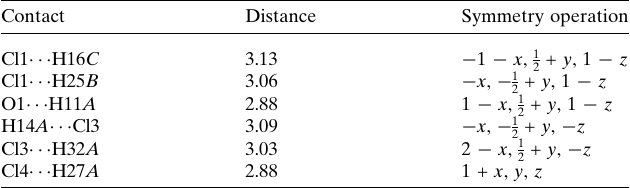
Table 2 Summary of short interatomic contacts (A˚ ) in the title compound. Contact